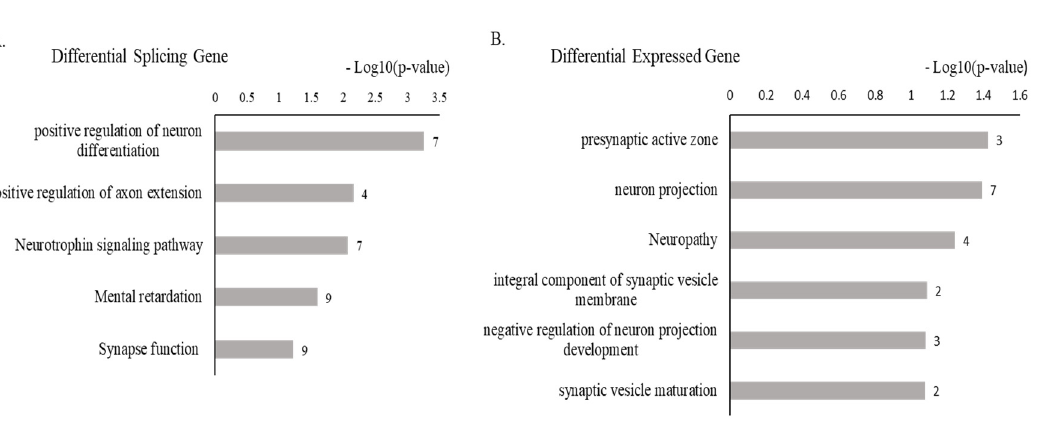
Figure 5. hnRNP A1 knockdown affects alternative splicing or expression of a subsets of genes with neuronal function. ( A ) Gene ontology analysis of differently spliced genes by hnRNP A1. ( B ) Gene ontology analysis of differently expressed genes by hnRNP A1.